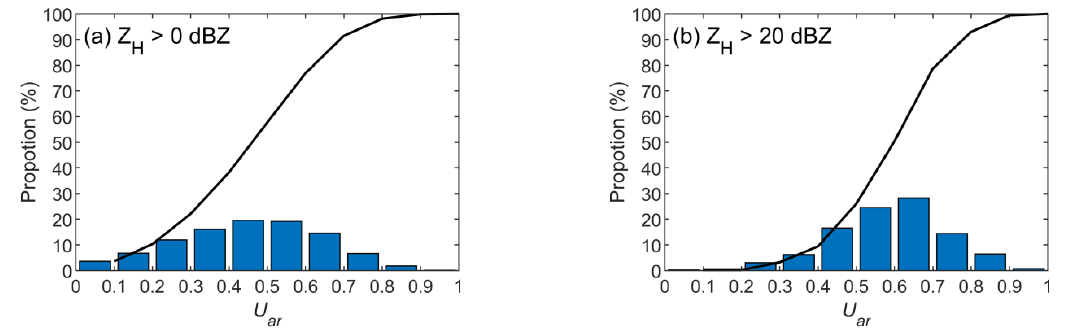
Figure 11. Proportions of U ar values in the warm layer (below 2.37 km, warmer than 9 ◦ C) of area A: ( a ) points with Z H > 0 dBZ and ( b ) points with Z H > 20 dBZ. The bars are the proportions within given ranges, and the black lines are the accumulated